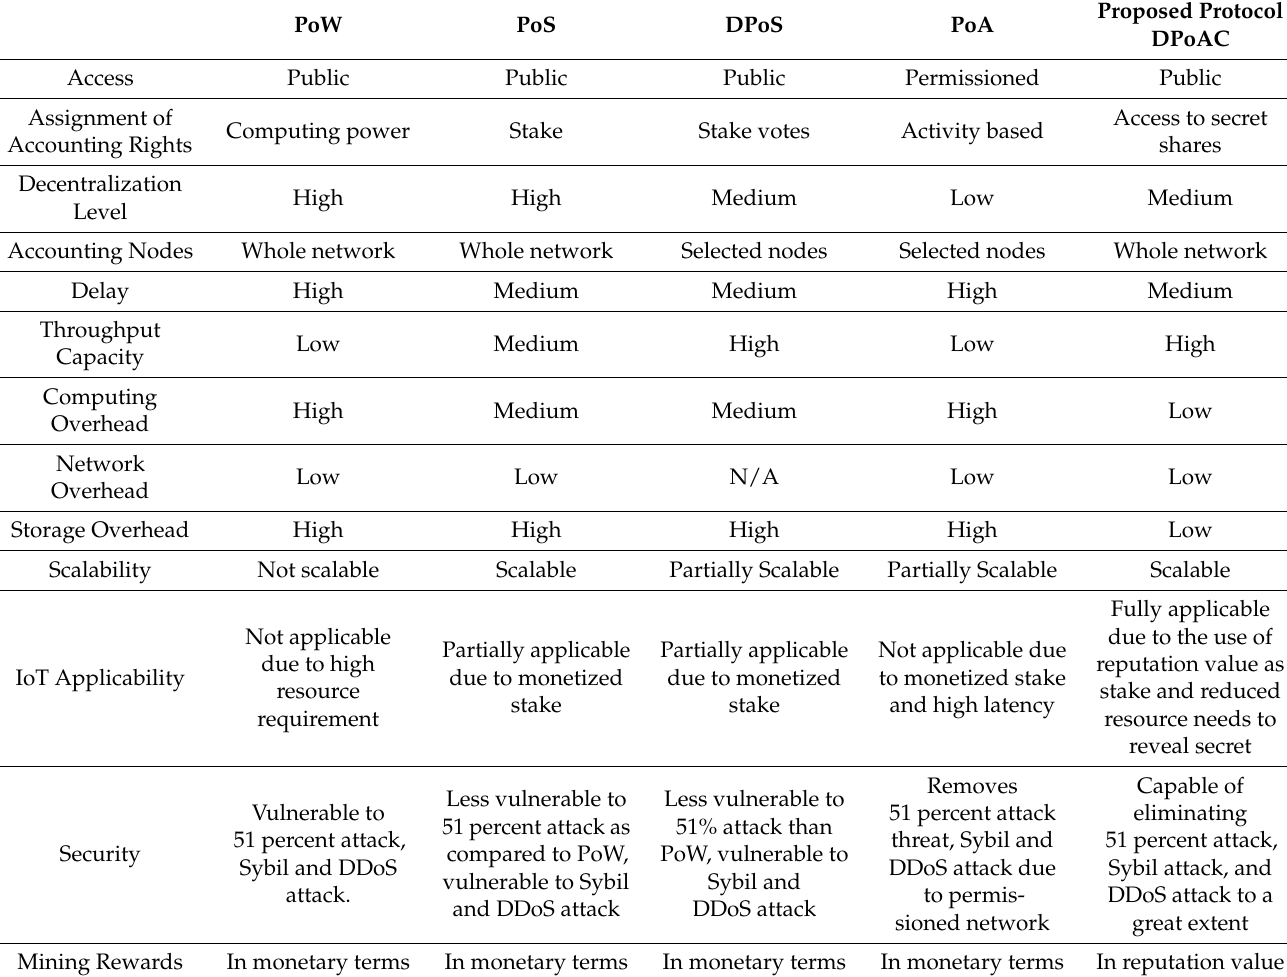
Table 1. Comparison of mainstream consensus algorithms against DPoAC